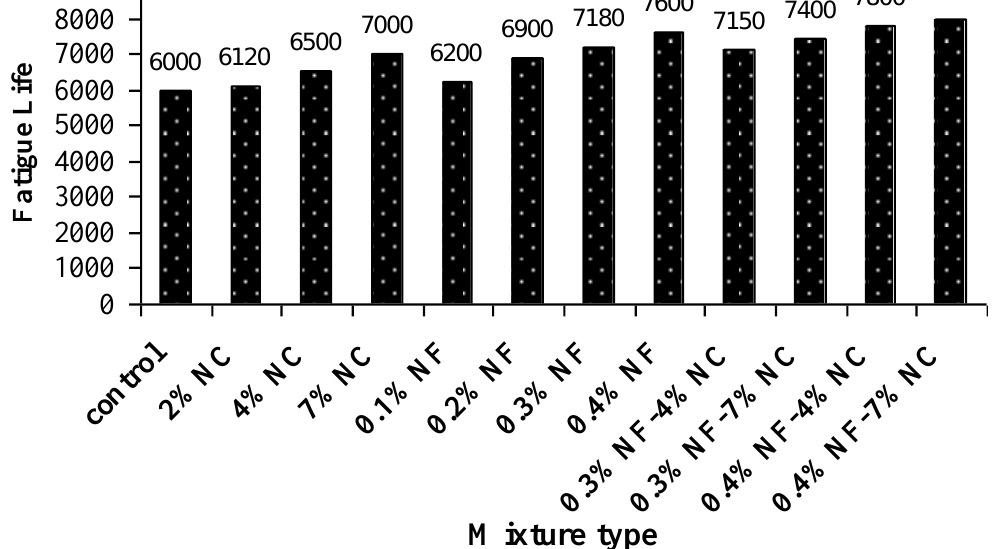
Fig. 8. Fatigue tests